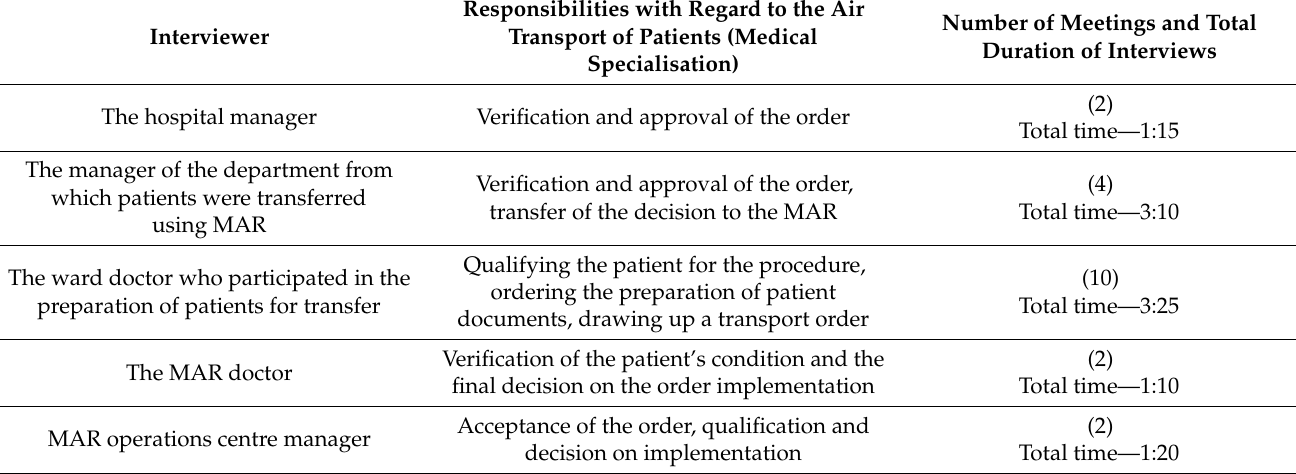
Table 1. Characteristics of the interviewed